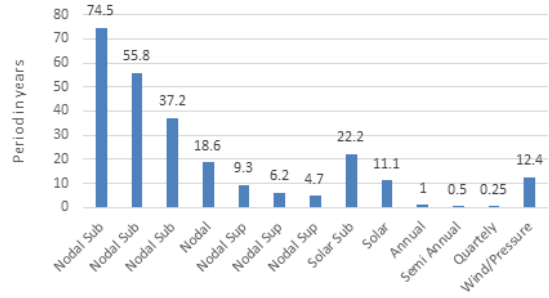
Fig. 2. Low frequency sea level variations experienced at globally distributed TG stations (Iz,